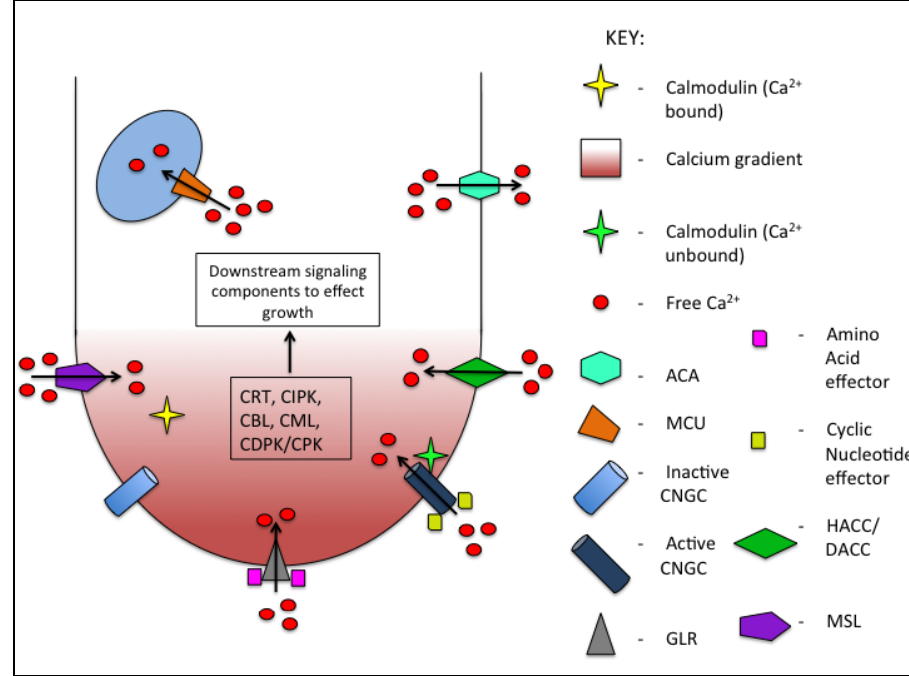
Figure 1. Overview of the actions of calcium signaling components. Calcium enters the cytoplasm of the tube through the activity of numerous membranous proteins including Cyclic nucleotide gated channels (CNGCs), Glutamate receptor-like channels (GLRs), Hyperpolarization/depolarization-activated calcium channels (HACC/DACCs), and MscS-like channels (MSLs). Calcium entry into the tube results in an elevation in calcium concentration. CNGCs and GLRs allow entry of calcium into the cytoplasm of the tube which causes an elevation in calcium concentration. CNGC is activated by calcium-free calmodulin. At critical calcium levels, calmodulin binds calcium causing its dissociation from the channel and the cessation of calcium entry. Calcium stimulates the activity of calcium-sensing proteins which result in calcium-mediated downstream signaling to affect growth. Mitochondrial calcium transporters (MCUs) in the mitochondrial membrane and autoinhibited Ca 2+ ATPases (ACAs) at the plasma membrane facilitate the efflux of calcium out of the pollen tube, resulting in basal calcium levels.